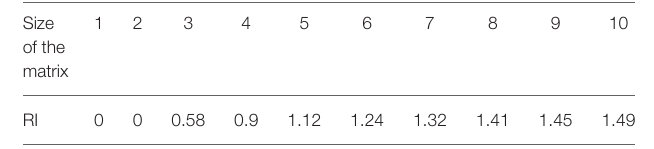
TABLE 2 | Relational data for constructing pair-wise comparisons (Chang et al., 2007).